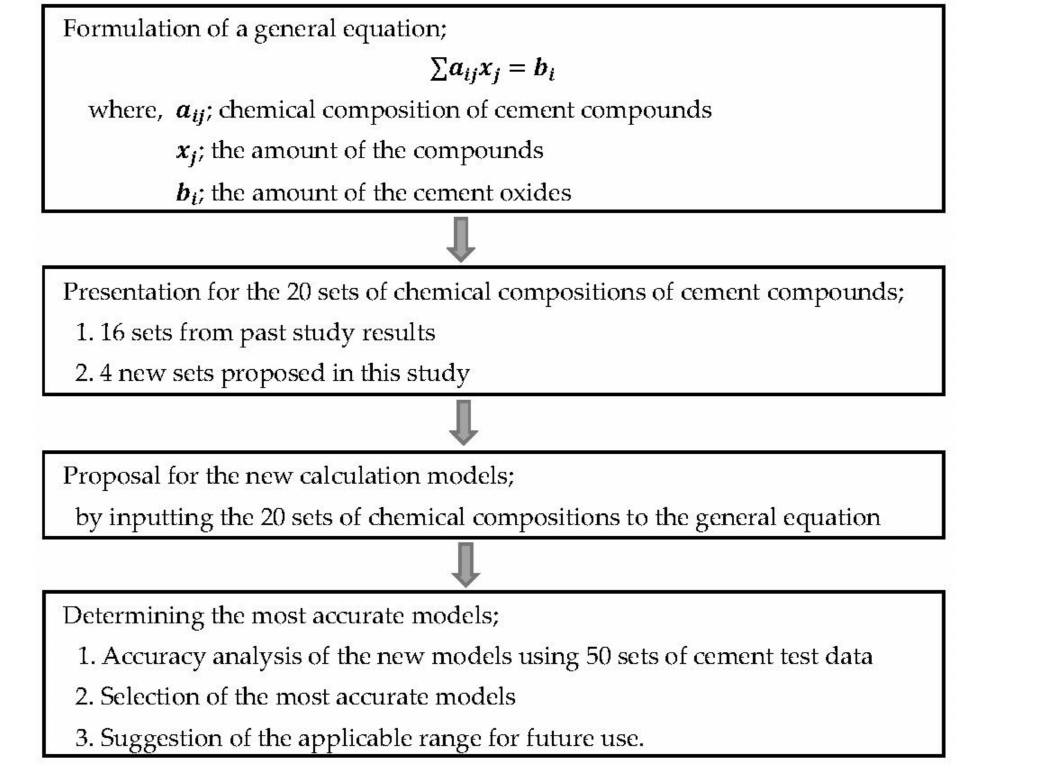
Figure 1. Overall procedure for the development of more accurate models to predict the cement com-